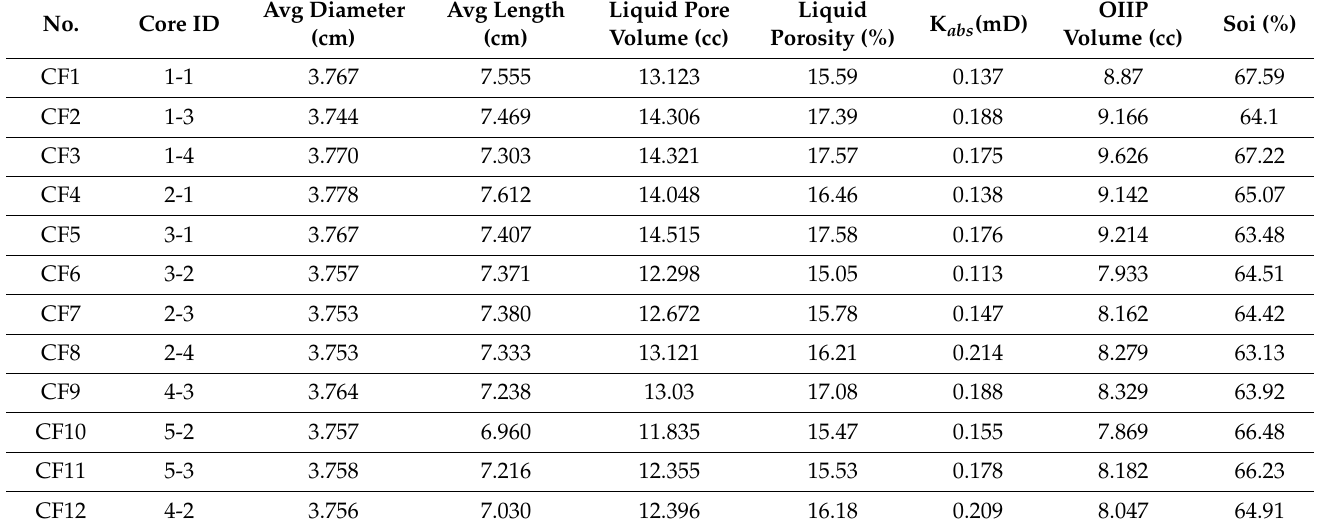
Table 3. Summary of core properties used for